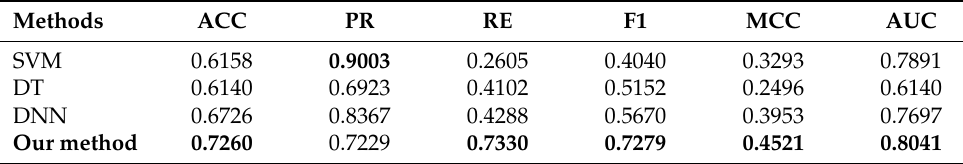
Table 1. The comparative benchmarks on the independent testing datasets of CSF.